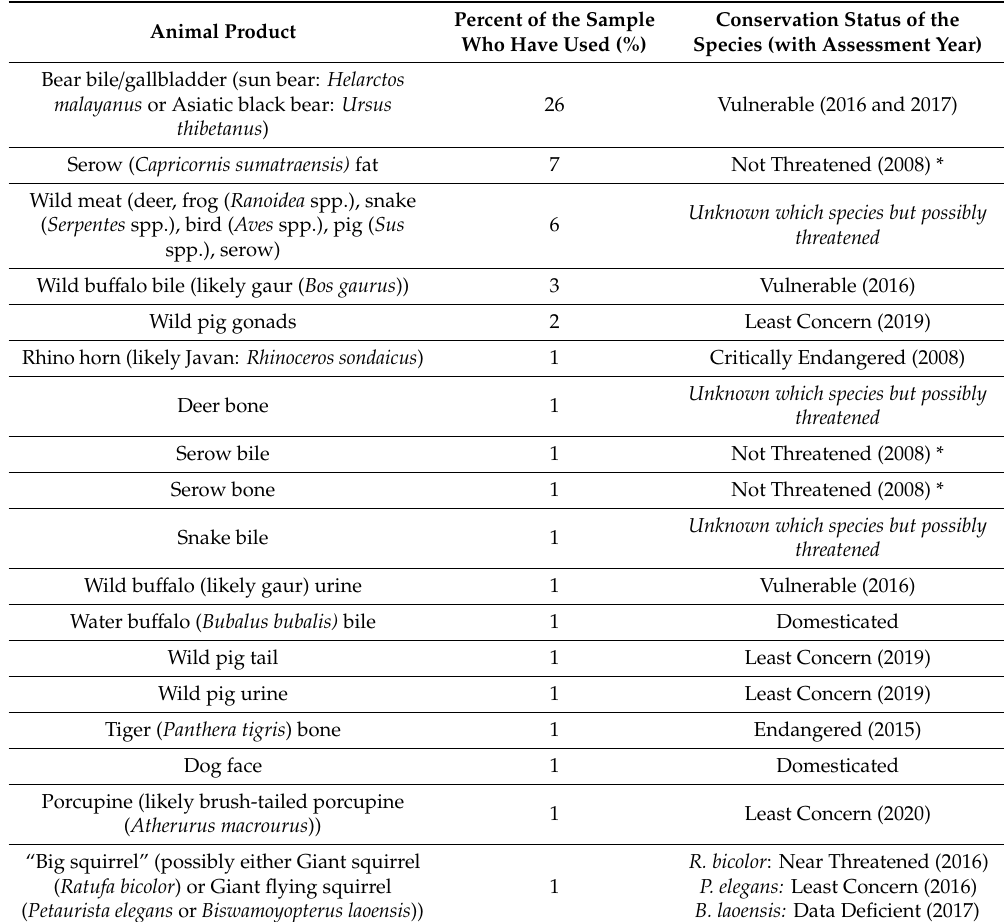
Table 2. Types of animal products consumed by the interviewees (in %), along with the conservation status of the